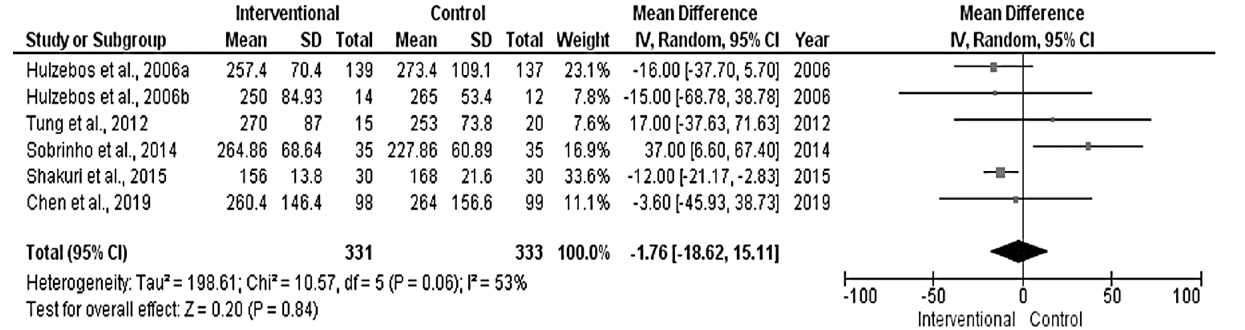
Figure 5. Forest plot evaluating hospital stay length in the included studies. The meta-analyses revealed significant differences between the interventional and control groups in the FEV1% predicted (Figure 6), FVC% predicted (Figure 7), and Pi-max (Figure 8) ( p < 0.05), favoring the interventional group. The pooled mean differences were 3.7%, 10.17%, and 17.25 cm H 2 O, respectively.